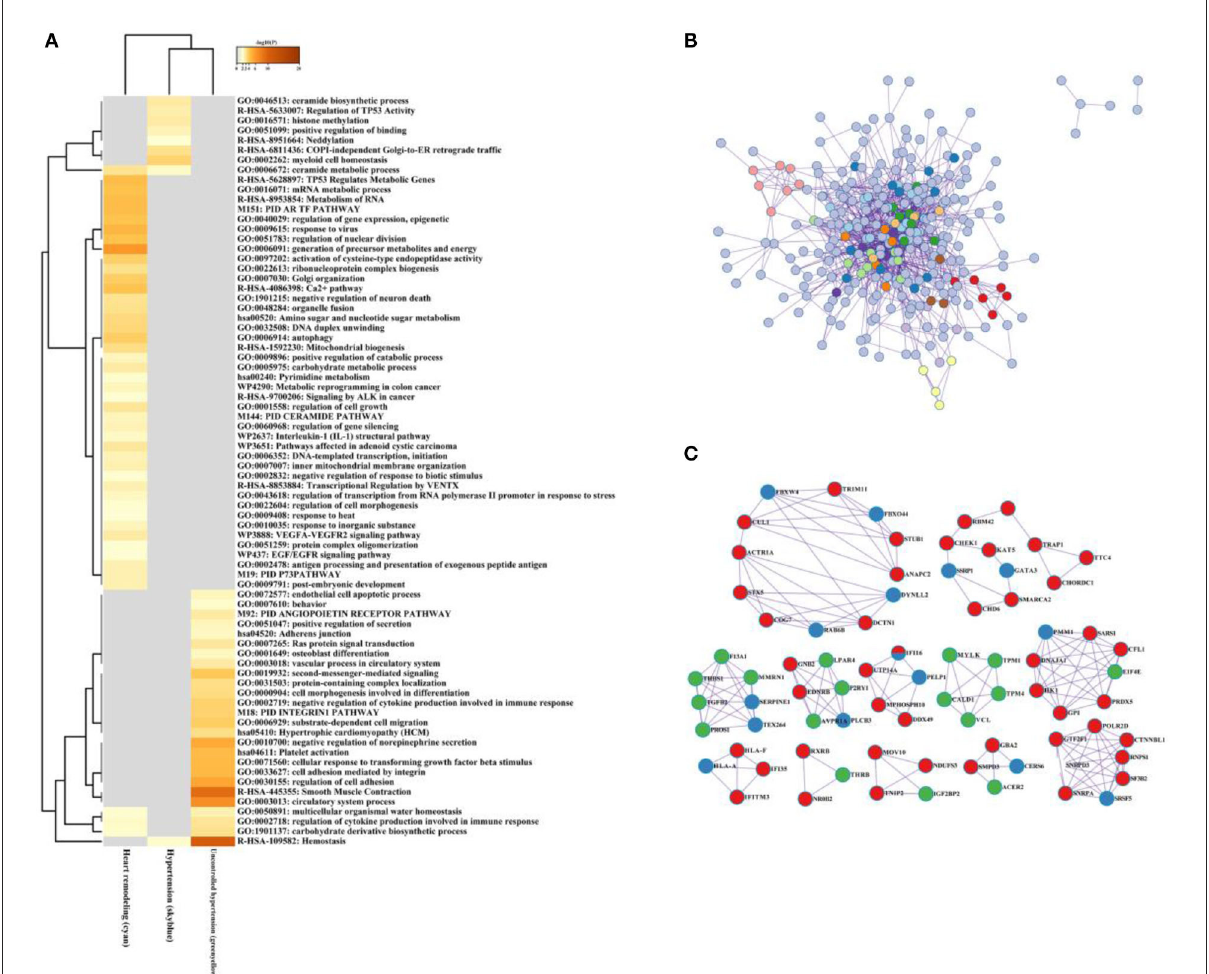
FIGURE8 The multiple gene module analysis across hypertension, uncontrolled hypertension, and hypertension with left ventricular remodeling. (A) Functional enrichment analysis for the multiple gene module. (B,C) Network construction, and hub genes selection and interaction for multiple gene module across hypertension, uncontrolled hypertension, and hypertension with left ventricular